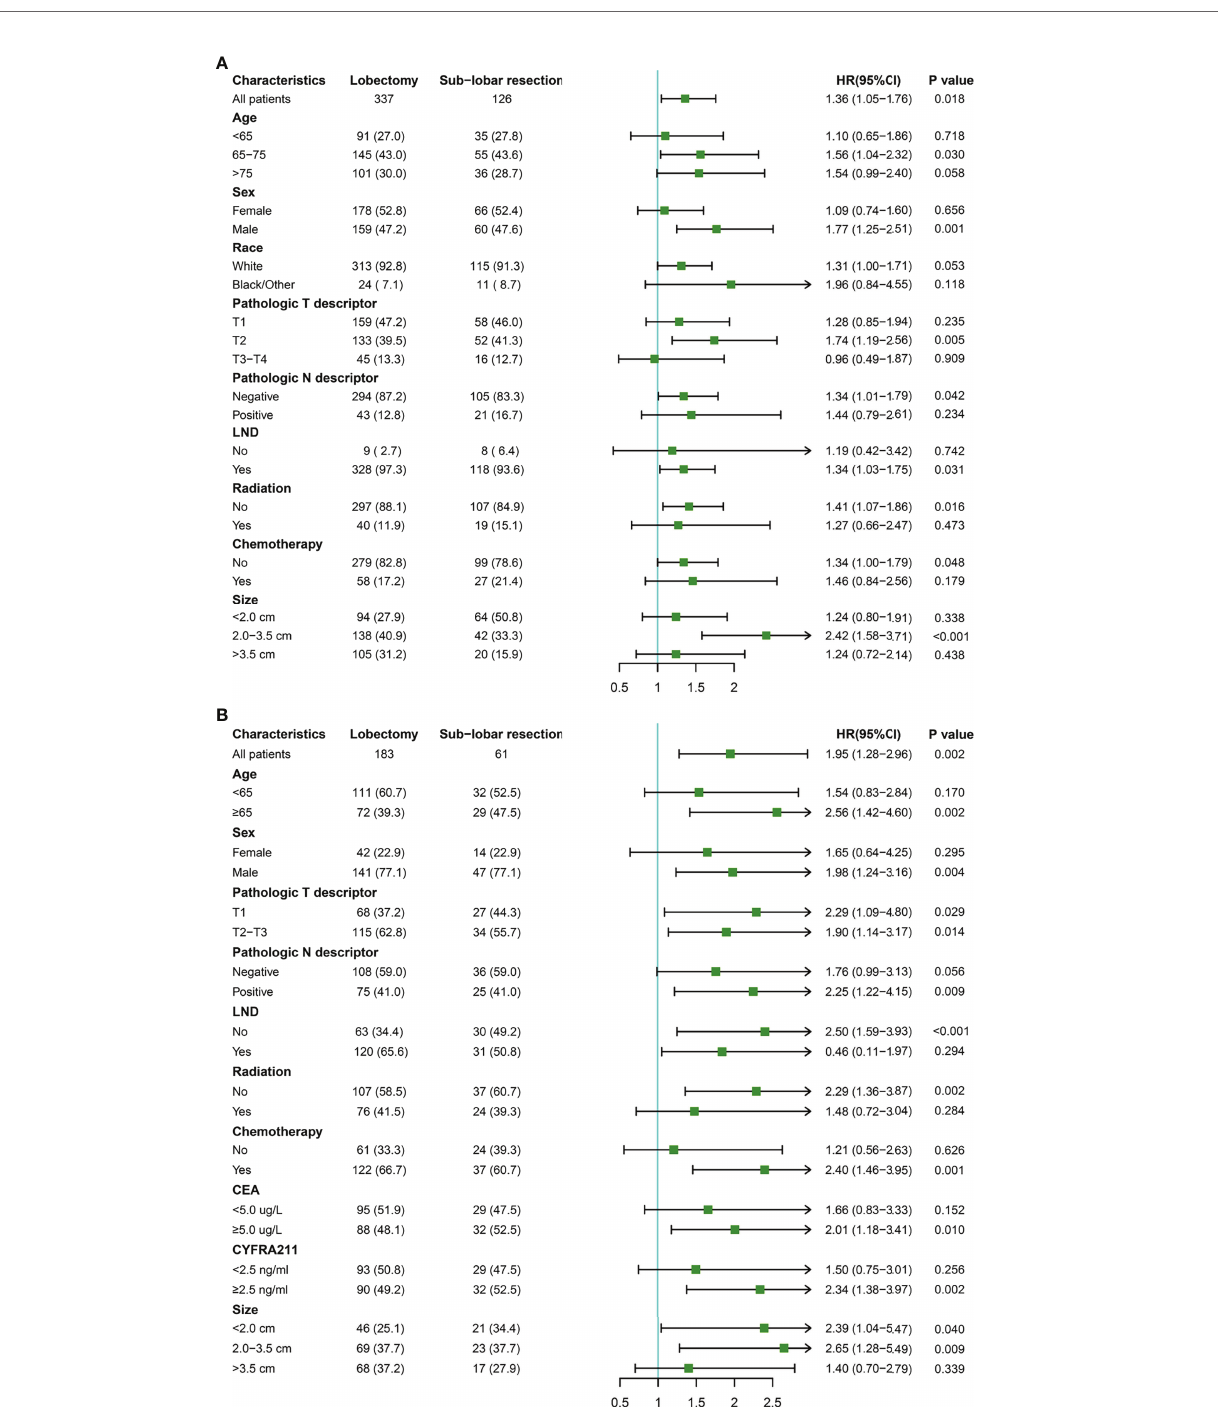
FIGURE 4 | Subgroup analysis for lung adenosquamous carcinoma patients according to surgery type. (A) the Surveillance, Epidemiology, and End Results cohort; (B) the Shanghai Pulmonary Hospital